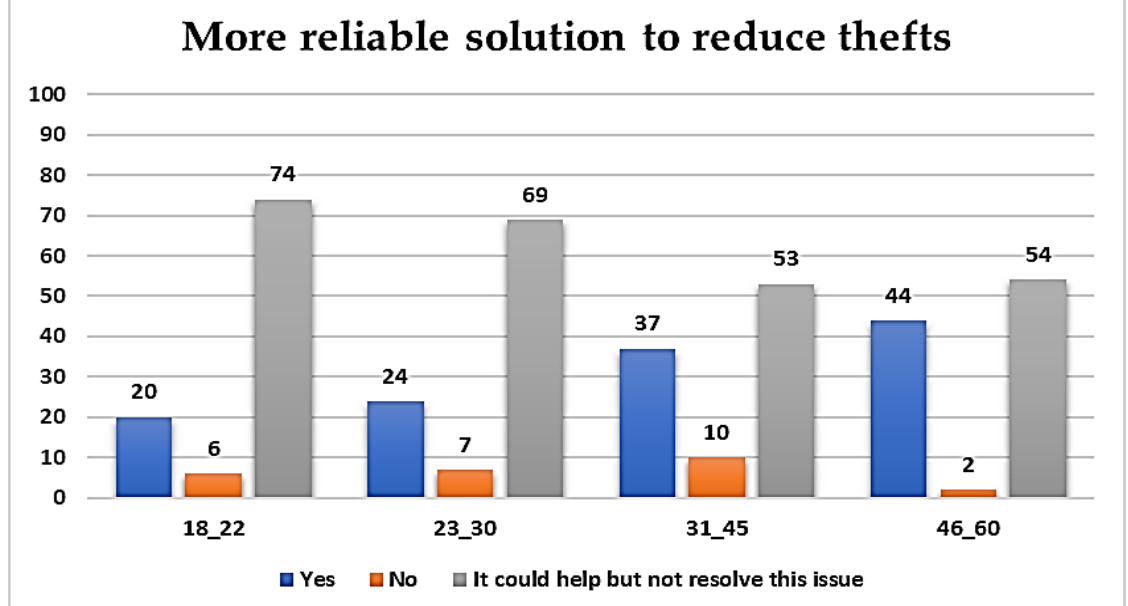
Figure 15. BS as a reliable solution to reduce thefts .